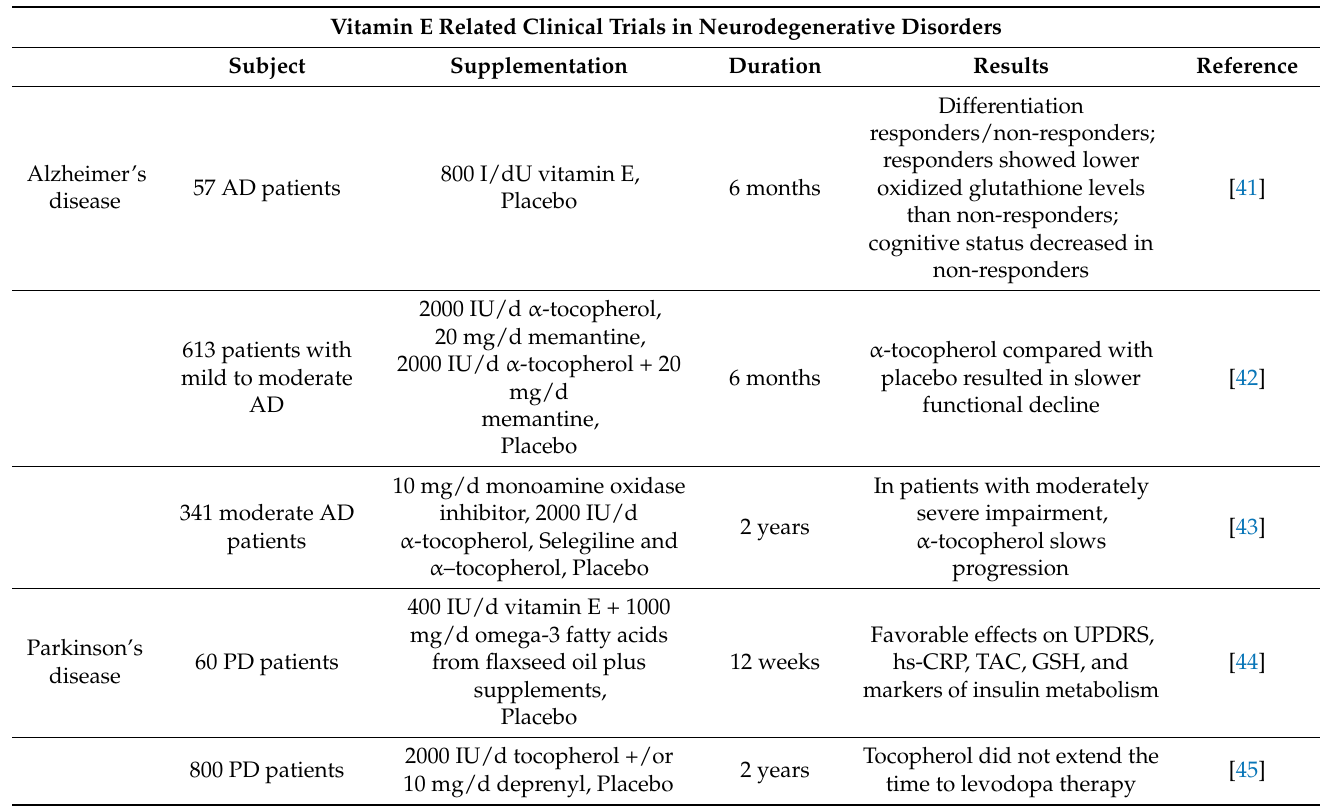
Table 2. Overview of relevant vitamin E-related clinical trials and results in neurodegenerative